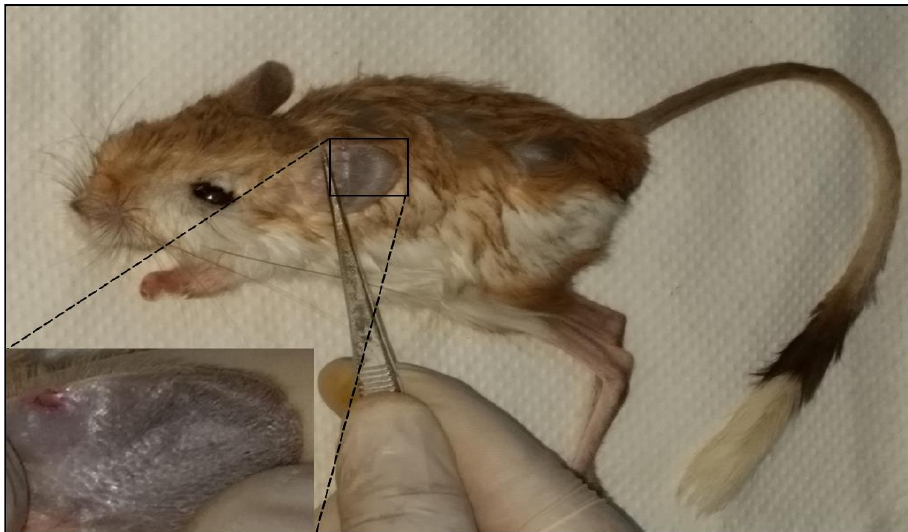
Figure 2. Jaculus jaculus presenting leishmaniasis clinical manifestation as a small nodule on the higher edge of the ear.